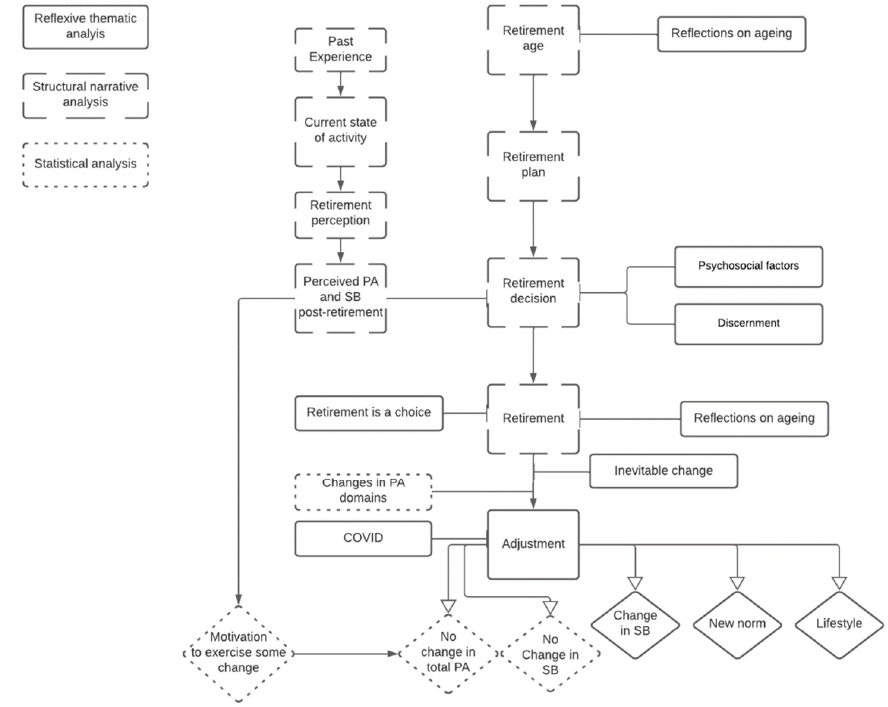
Figure 3. Data integration flowchart. Table 8. Table to show meta-inferences.